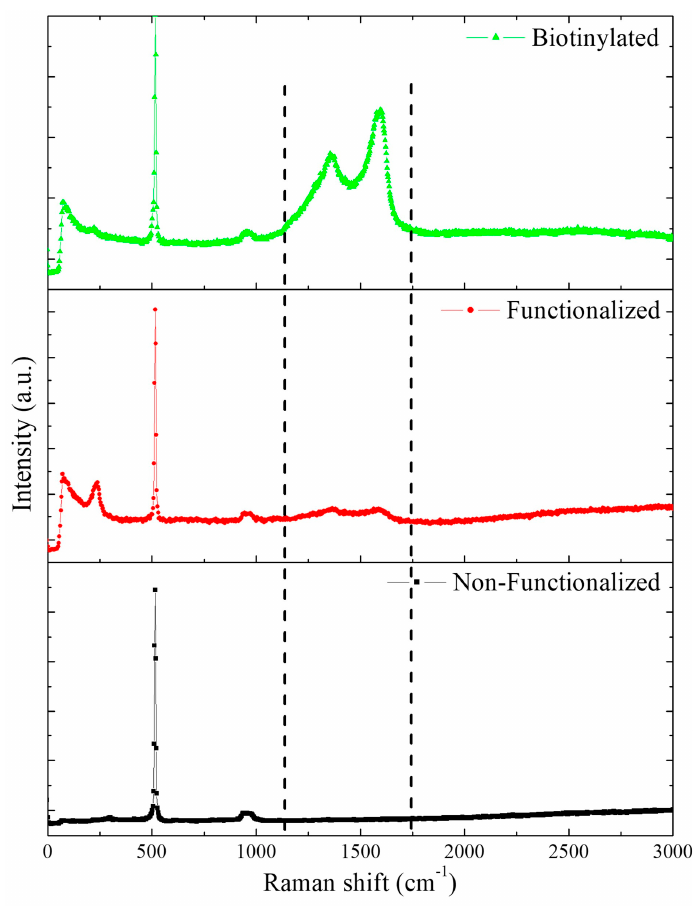
Figure 3. Raman spectra of the hydroxylated Si 3 N 4 surface (black line), after functionalization (red line) and after biotinylation (green line).